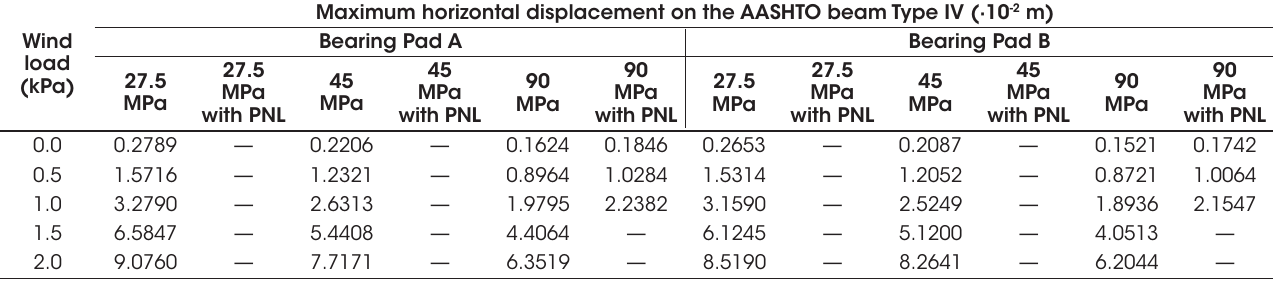
Maximum horizontal displacement on the AASHTO beam Type IV Wind load